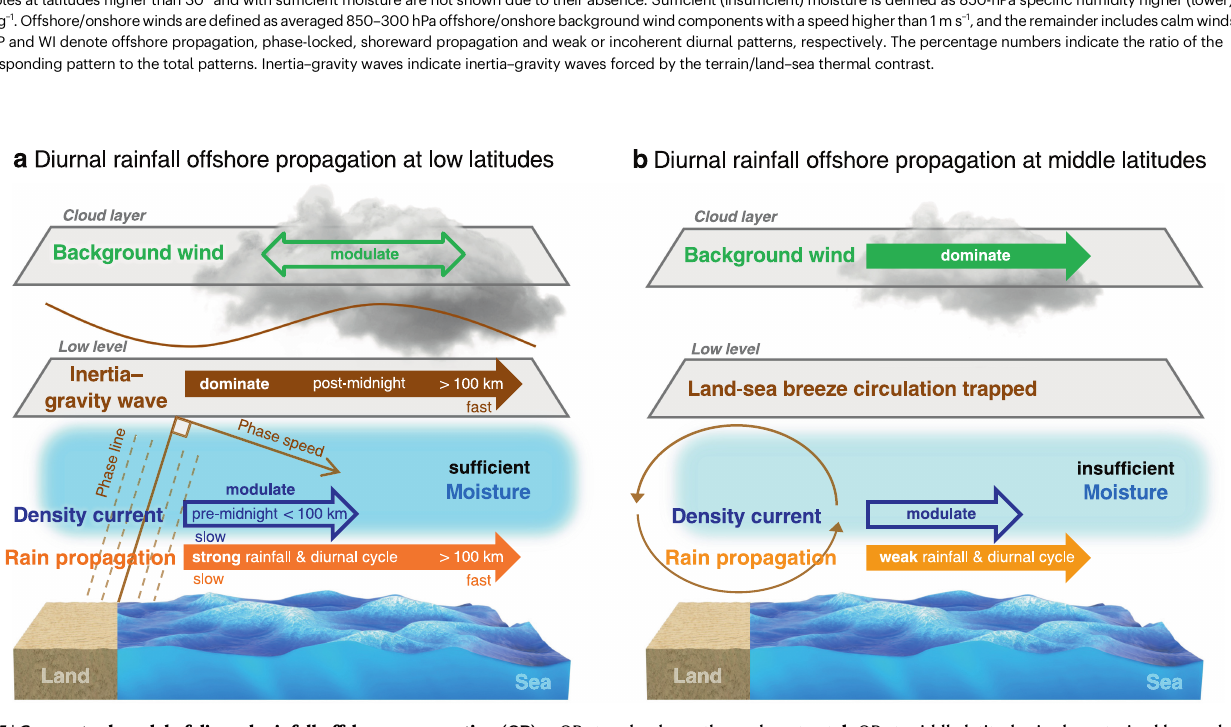
land – sea thermal contrast. b OP at middle latitudes is characterised by weaker rainfall and diurnal cycle, and is signi fi cantly in fl uenced by the direction of back- ground winds under trapped land – sea breeze circulation